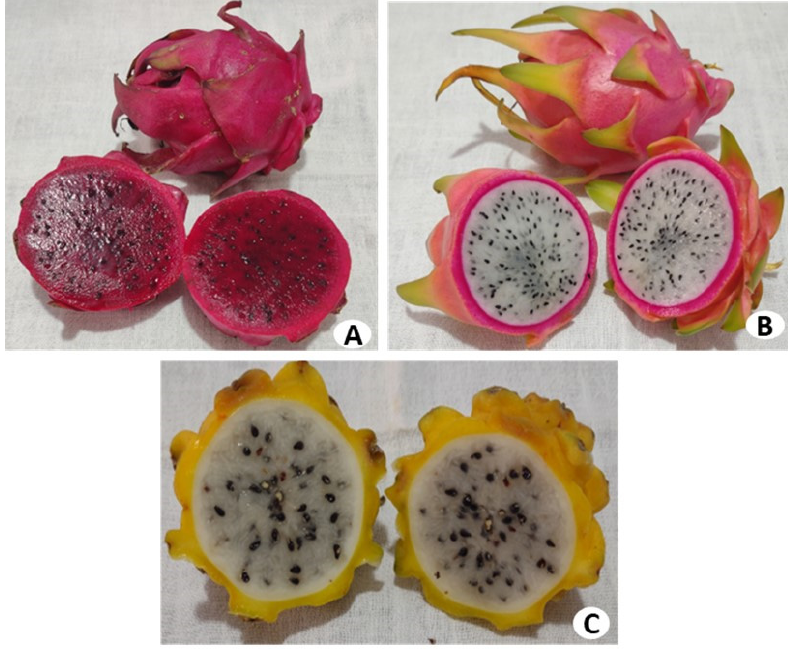
Figure 2. The fruit of H. polyrhizus ( A ), H. undatus ( B ), and H. megalanthus ( C ).